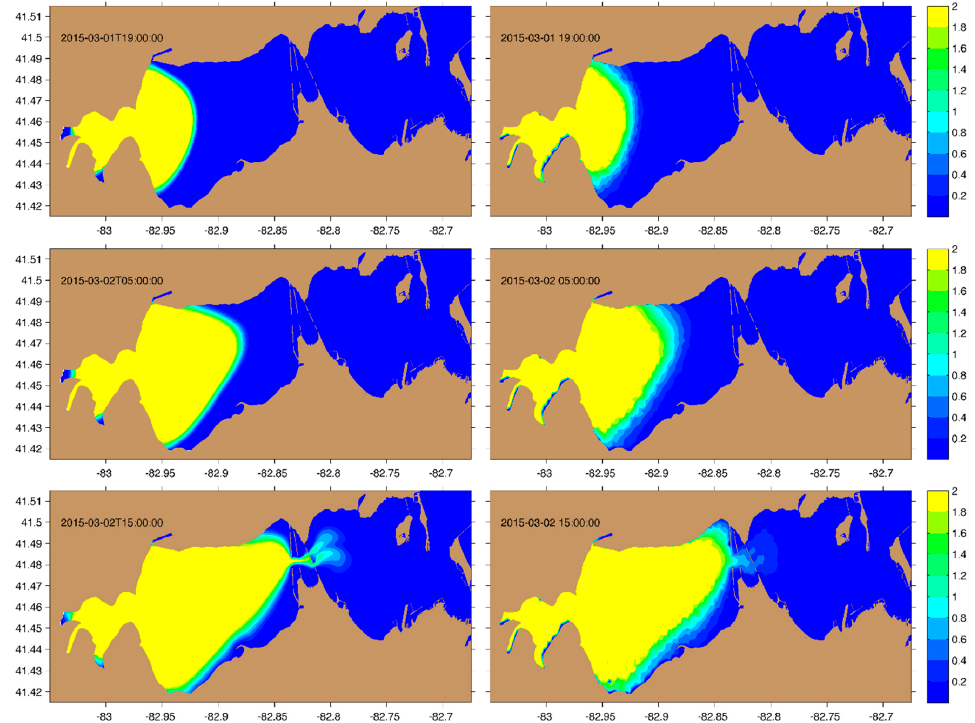
Figure 8. River plumes at selected times (labelled in each panel) simulated with conventional soluble-tracer model ( left panels) and PCPM model ( right panels). The color scale represents the tracer concentration.